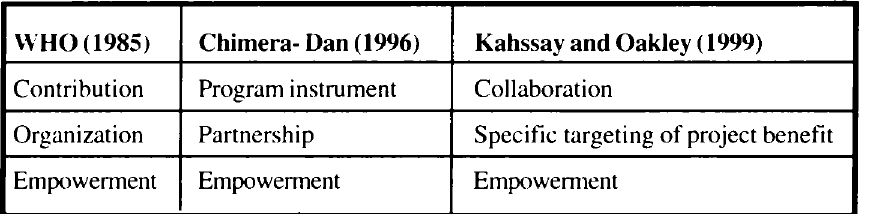
Table 1: Illustrating three forms of community involvement